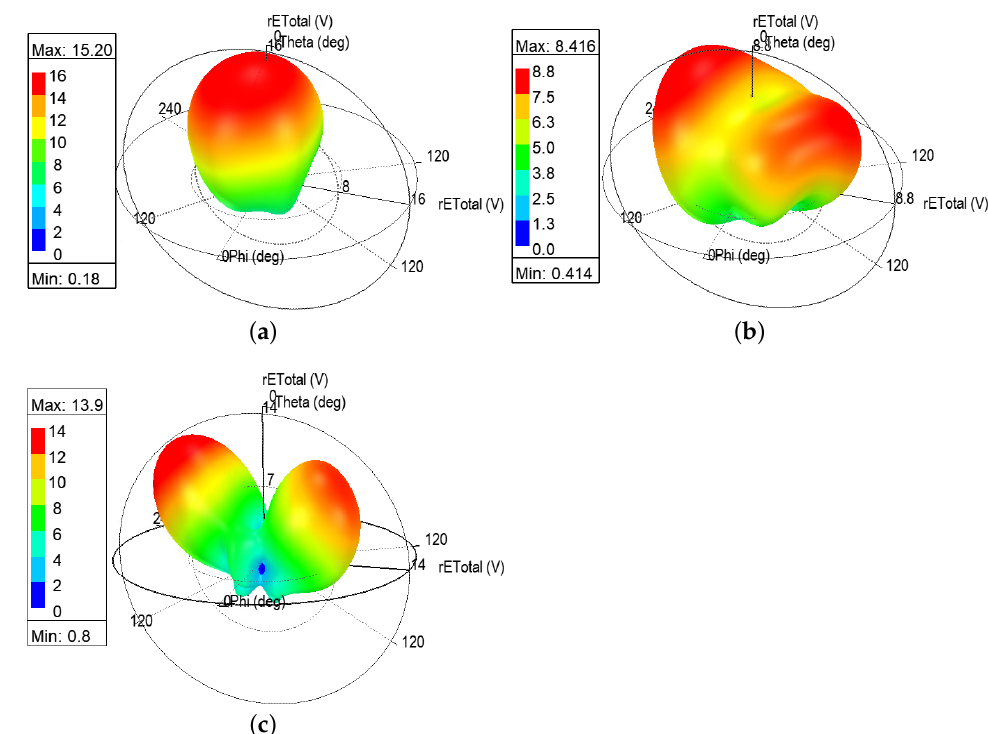
Figure 14. Electric field 3D polar plot for cylinder radius of 80 mm. ( a ) Electric field 3D polar plot at 5.8 GHz; ( b ) Electric field 3D polar plot at 6.2 GHz; and ( c ) Electric field 3D polar plot at 8.4